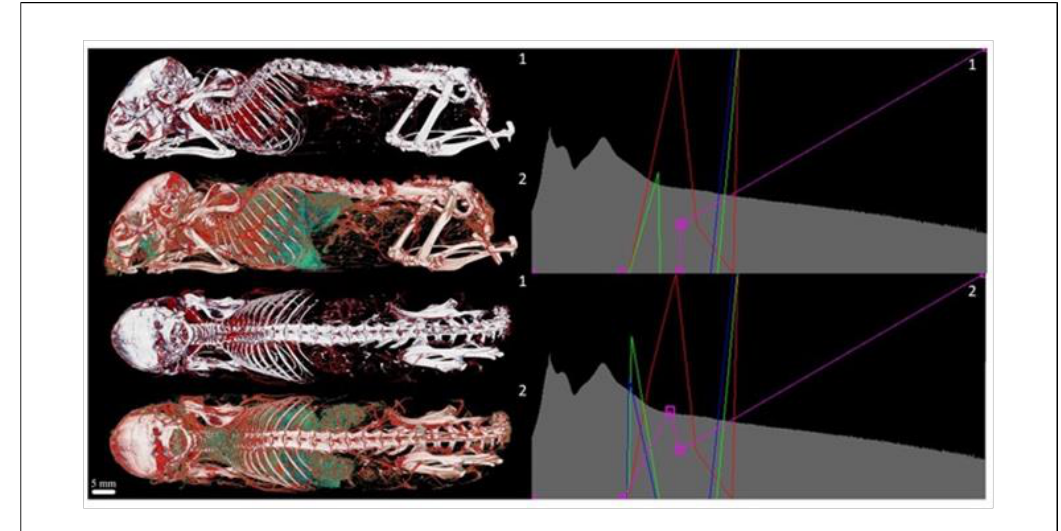
Figure 11. Transfer functions comparison — mouse (Aurovist, 42 kV).